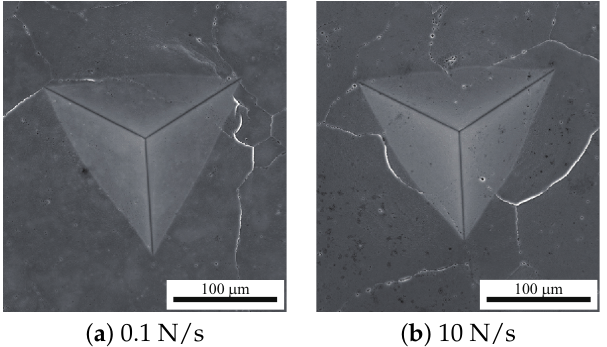
Figure 3. Impressions of high-temperature indentation tests in loading rates of 0.1 and 10